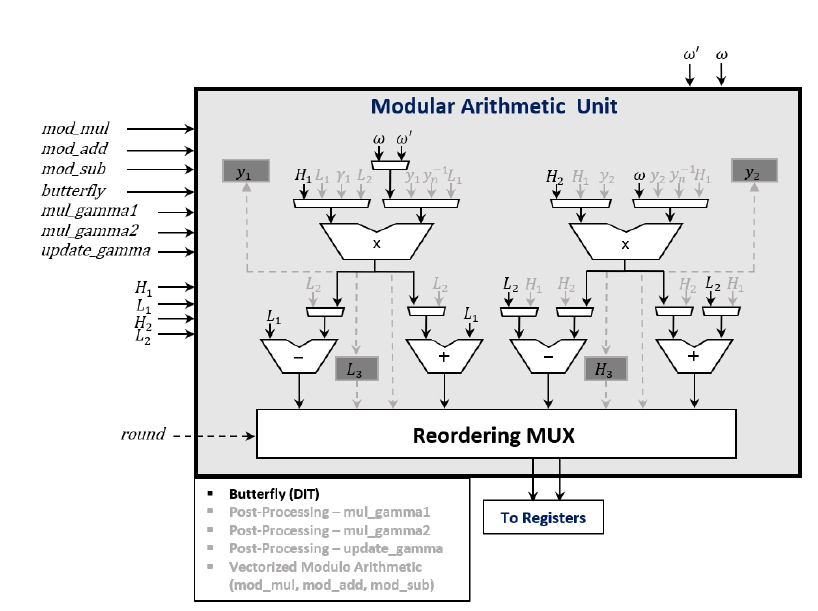
Figure 3: Modular Arithmetic Unit – Butterfly Operation decimation-in-time (DIT) MUX is responsible for preparing the coefficients to the next round (layer) by swapping the coefficients after the butterfly operation for all rounds, except for the last one.